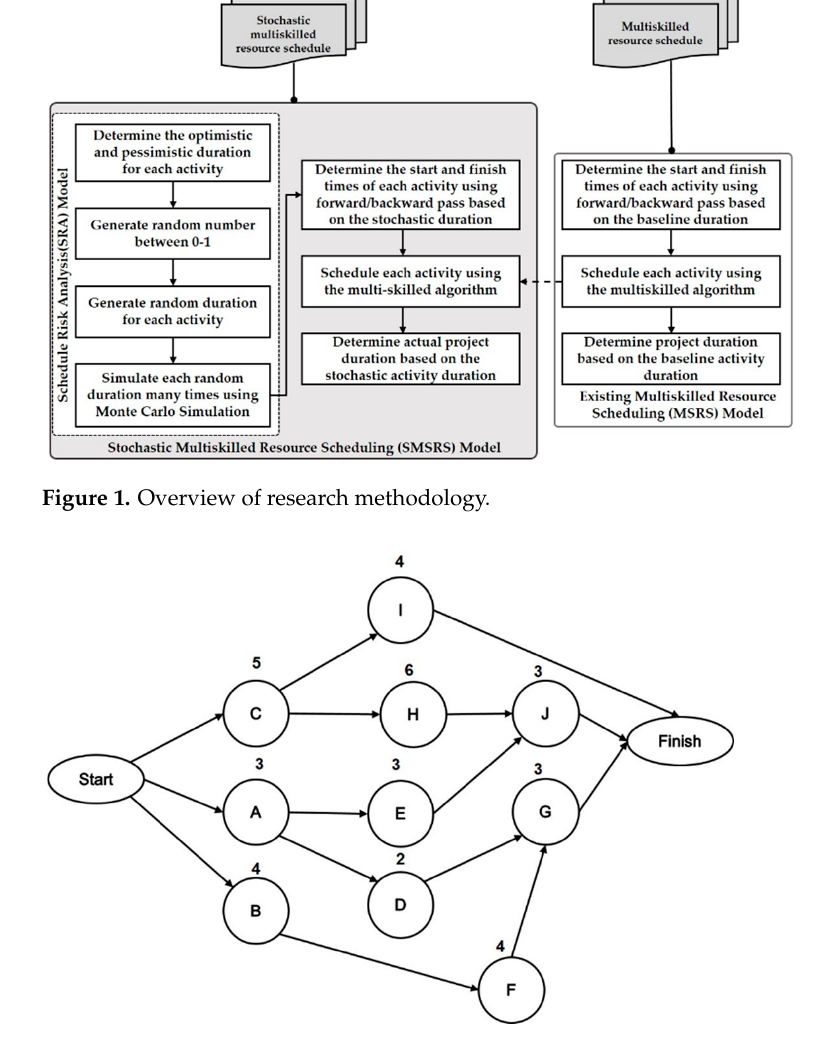
Figure 2. Network diagram for project A. Table 2. Project information for project